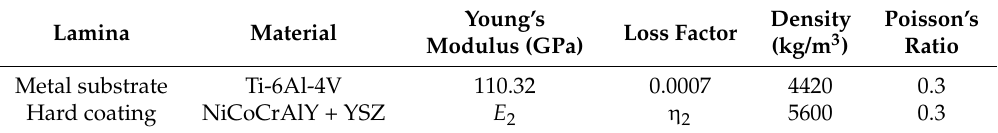
Table 2. Material parameters of the hard-coating cylindrical